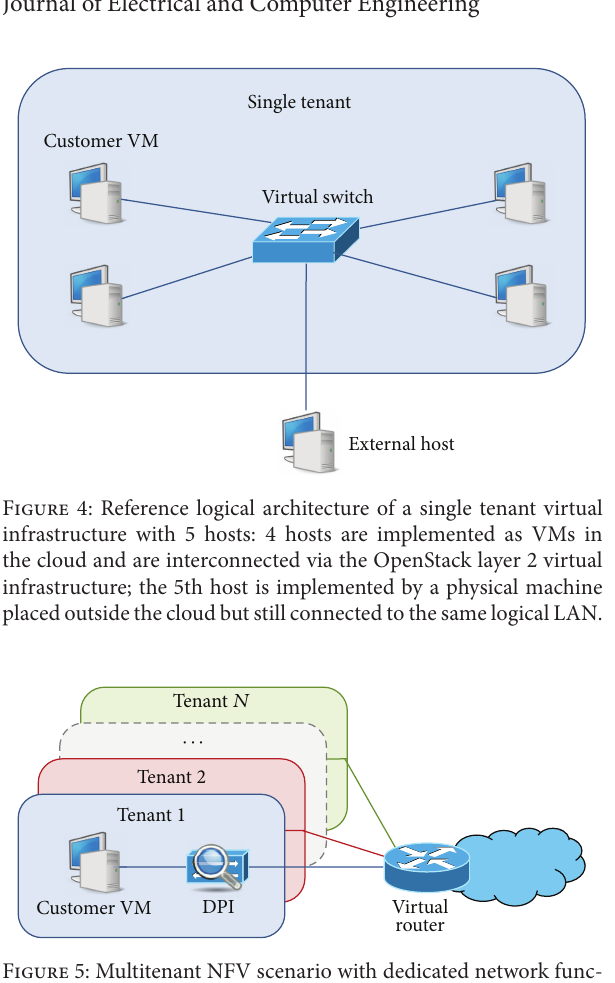
Figure 5: Multitenant NFV scenario with dedicated network func- tions tested on the OpenStack